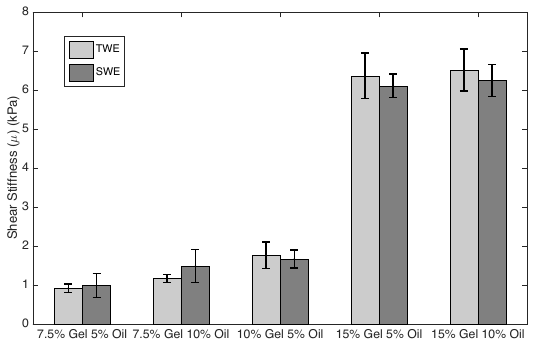
Figure 14. Mean and standard deviations of the shear elasticity for each batch of gelatine. Light gray bars represent TWE measurements whilst those in dark gray show SWE measurements.